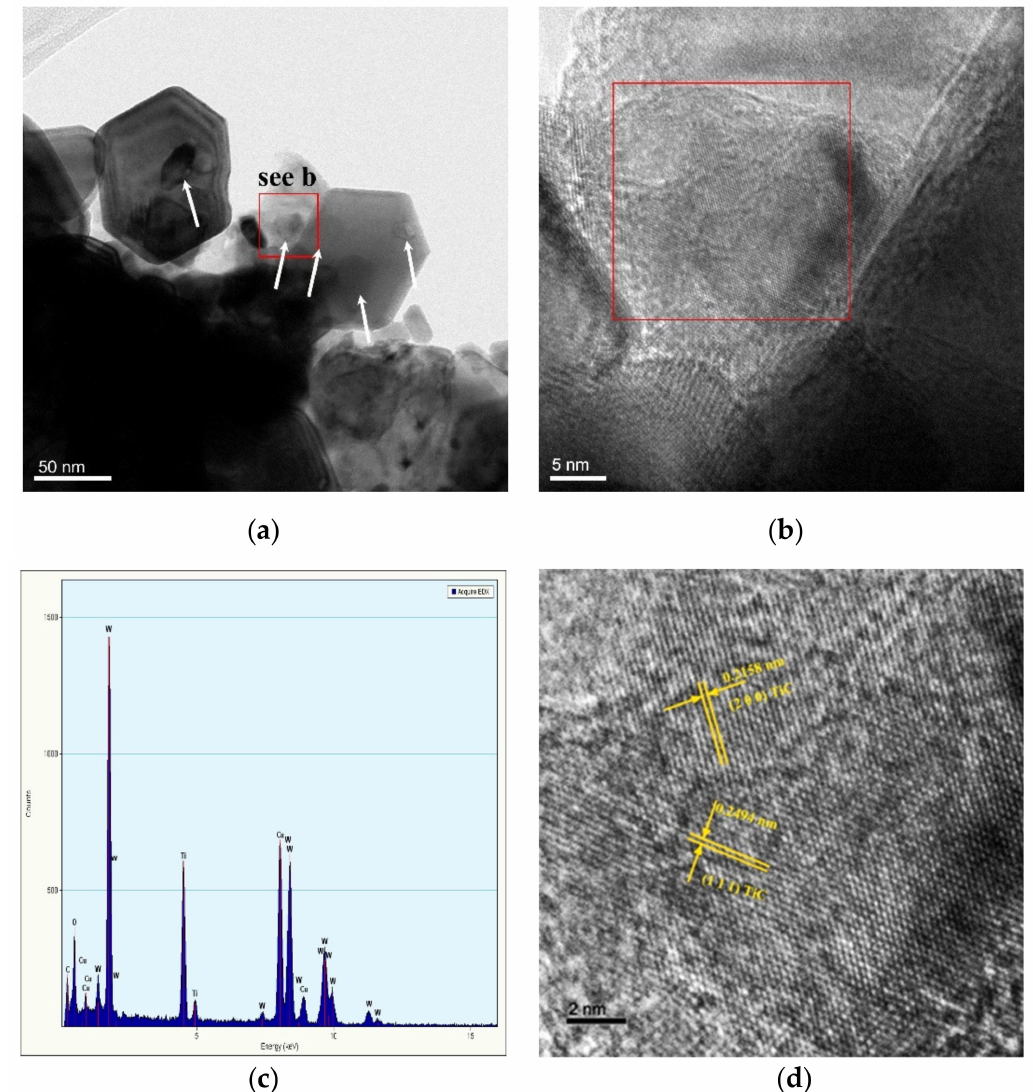
Figure 3. ( a , b ) TEM images of the reduced W-TiC powders, ( c ) EDS spectrum of the selected rectangle region in ( b ), and ( d ) high-resolution TEM image of the selected rectangle region in ( b